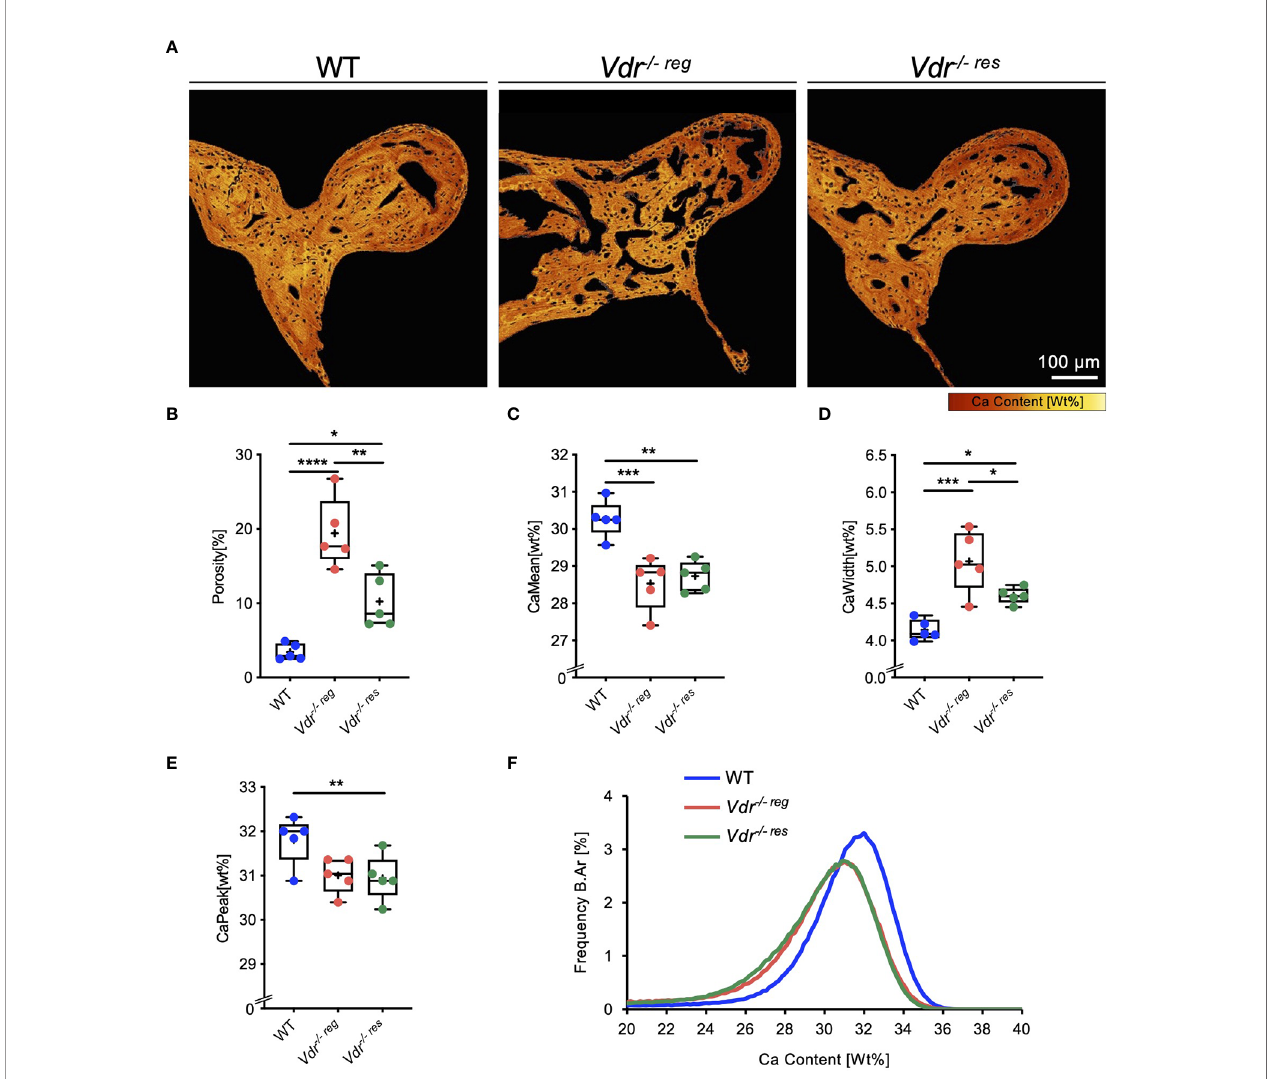
FIGURE 1 | Partial reversibility of porosity and bone mineral density distribution (BMDD) in the malleus evaluated by qBEI. (A) Representative, pseudo-colored images of the qBEI analysis of the orbicular apophysis of the malleus in WT, Vdr -/- reg and Vdr -/- res mice. The evaluation was based on the quanti fi cation of the (B) porosity, (C) mean calcium content (CaMean), (D) mineralization heterogeneity (CaWidth), and (E) peak of the calcium distribution (CaPeak). (F) Bone mineral density distribution (BMDD) histograms of the malleus of WT (Blue curve), Vdr -/- reg (red curve), Vdr -/- res mice (green curve). ANOVA and repeated measures with Holm-Sidak correction was performed in panels B-E. *p<0.05; **p<0.01, ***p<0.001,